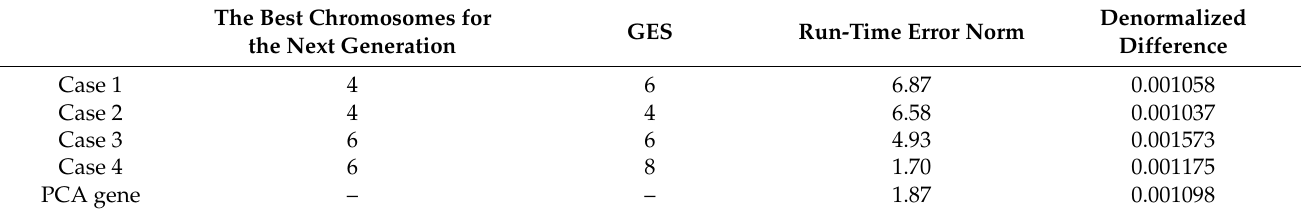
Table 6. The ANN training result under GA “progressing” optimizer.